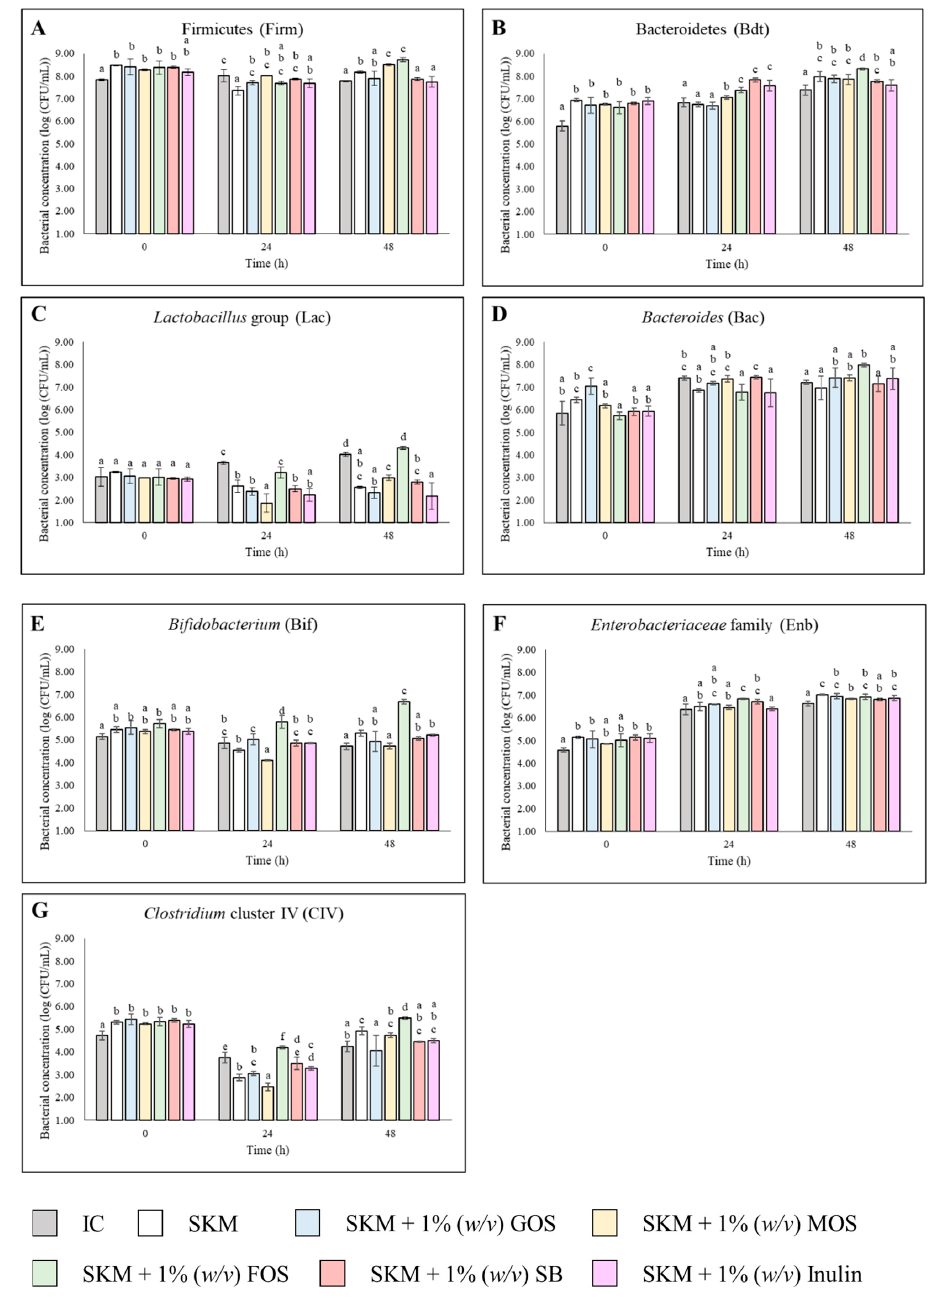
Figure 1. ( A – G )—Bacterial quantification (log (CFU/mL), mean ± SD) of the different bacterial populations present in the fecal fermentations for the different condition. ( A ) Firmicutes (Firm), ( B ) Bacteroidetes (Bdt), ( C ) Lactobacillus group (Lac), ( D ) Bacteroides (Bac), ( E ) Bifidobacterium (Bif), ( F ) Enterobacteriaceae family (Enb) and ( G ) Clostridium cluster IV (CIV). Different letters mark statistically significant ( p < 0.05) differences between each condition for each bacterial group at the same sam- pling time. IC—inoculum control; SKM—skim milk; GOS—galacto-oligosaccharide; MOS—mannan- oligosaccharides; FOS—fructo-oligosaccharides; SB— S. boulardii